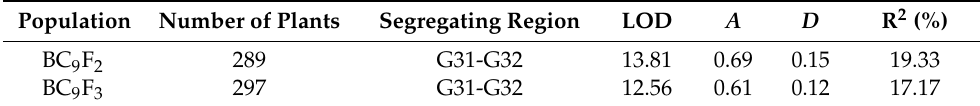
Table 4. QTL detected for TGW in the BC 9 F 2 and BC 9 F 3